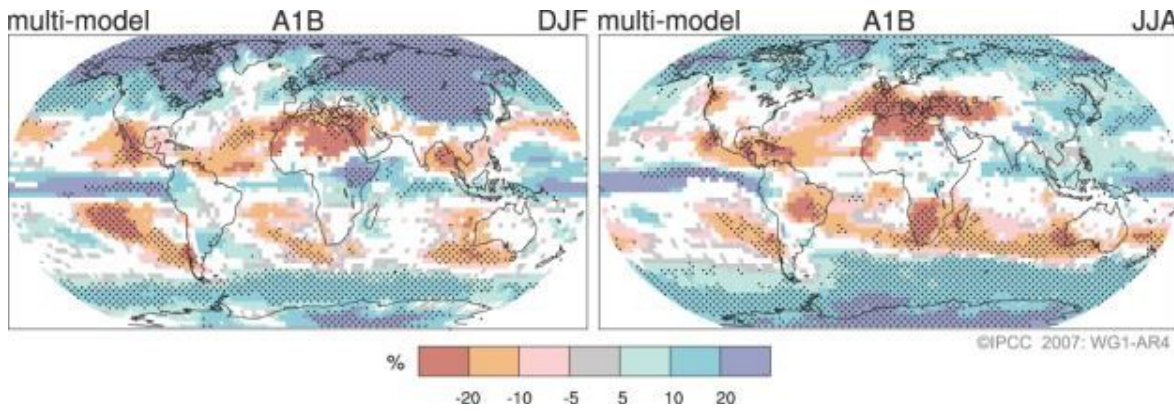
Figure 2. Projected relative changes in precipitation (in percent) for the period 2090–2099, relative to 1980–1999. Values are multi-model averages for December to February ( left ) and June to August ( right ). White areas are where less than 66% of the models agree in the sign of the change and stippled areas are where more than 90% of the models agree in the sign of the change. Figure from the Fourth Assessment Report of the Intergovernmental Panel on Climate Change